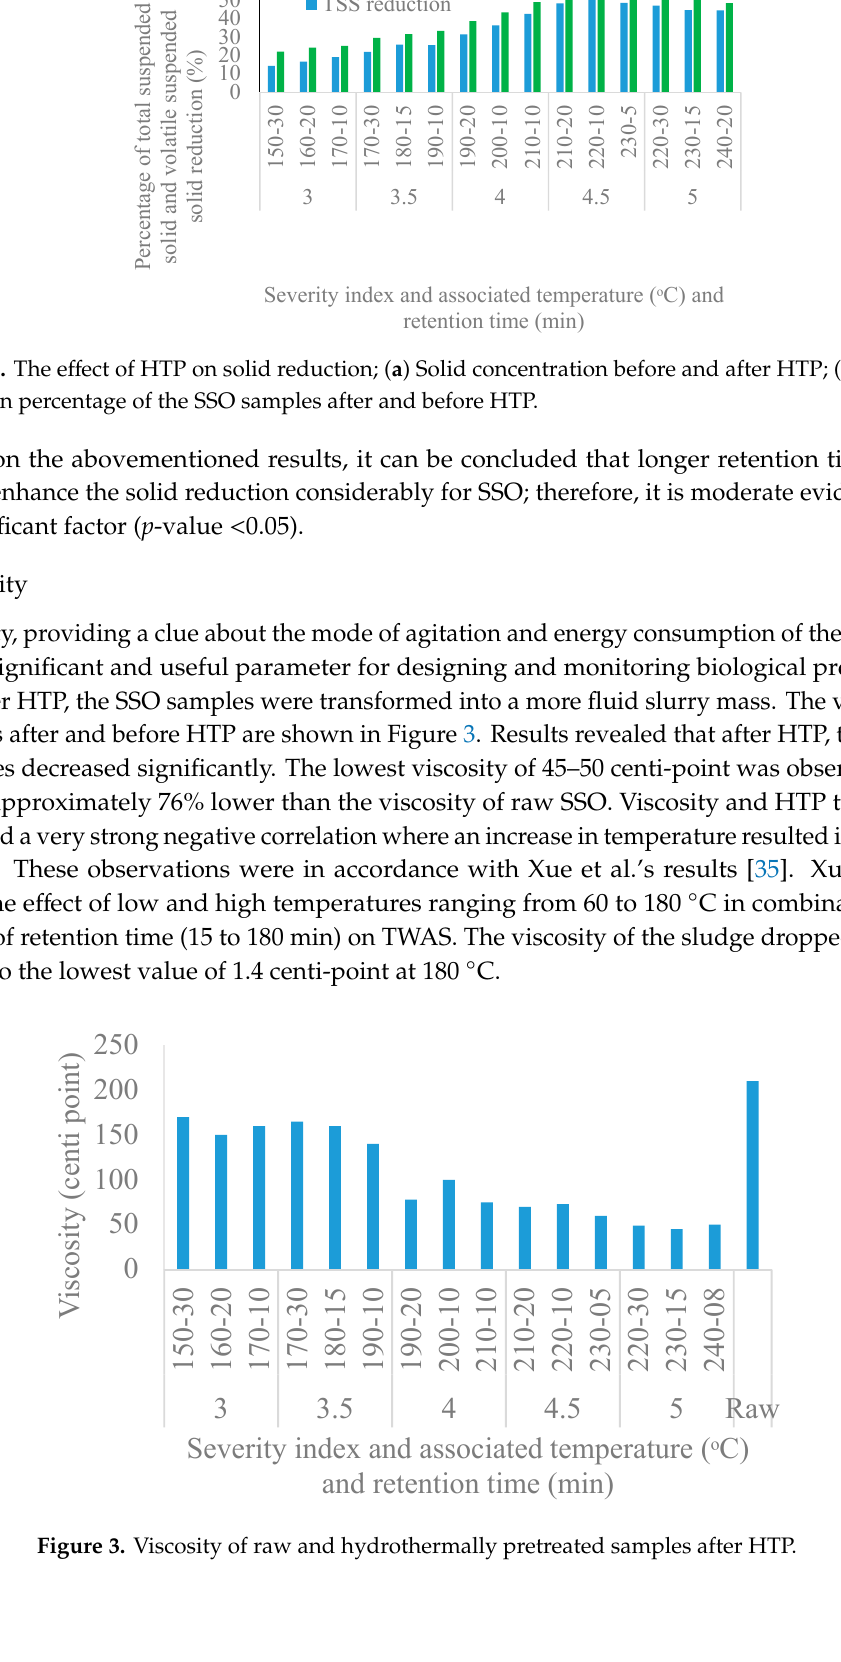
Figure 3. Viscosity of raw and hydrothermally pretreated samples after HTP.